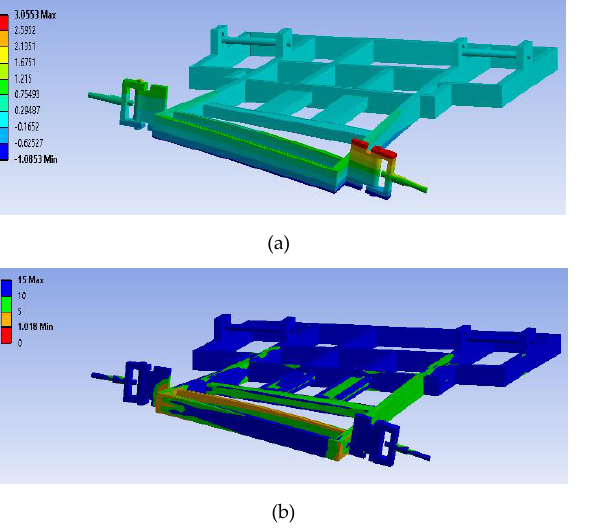
Figure 15: Deformation (a) and safety factor (b) of the fourth varia- tion of chassis